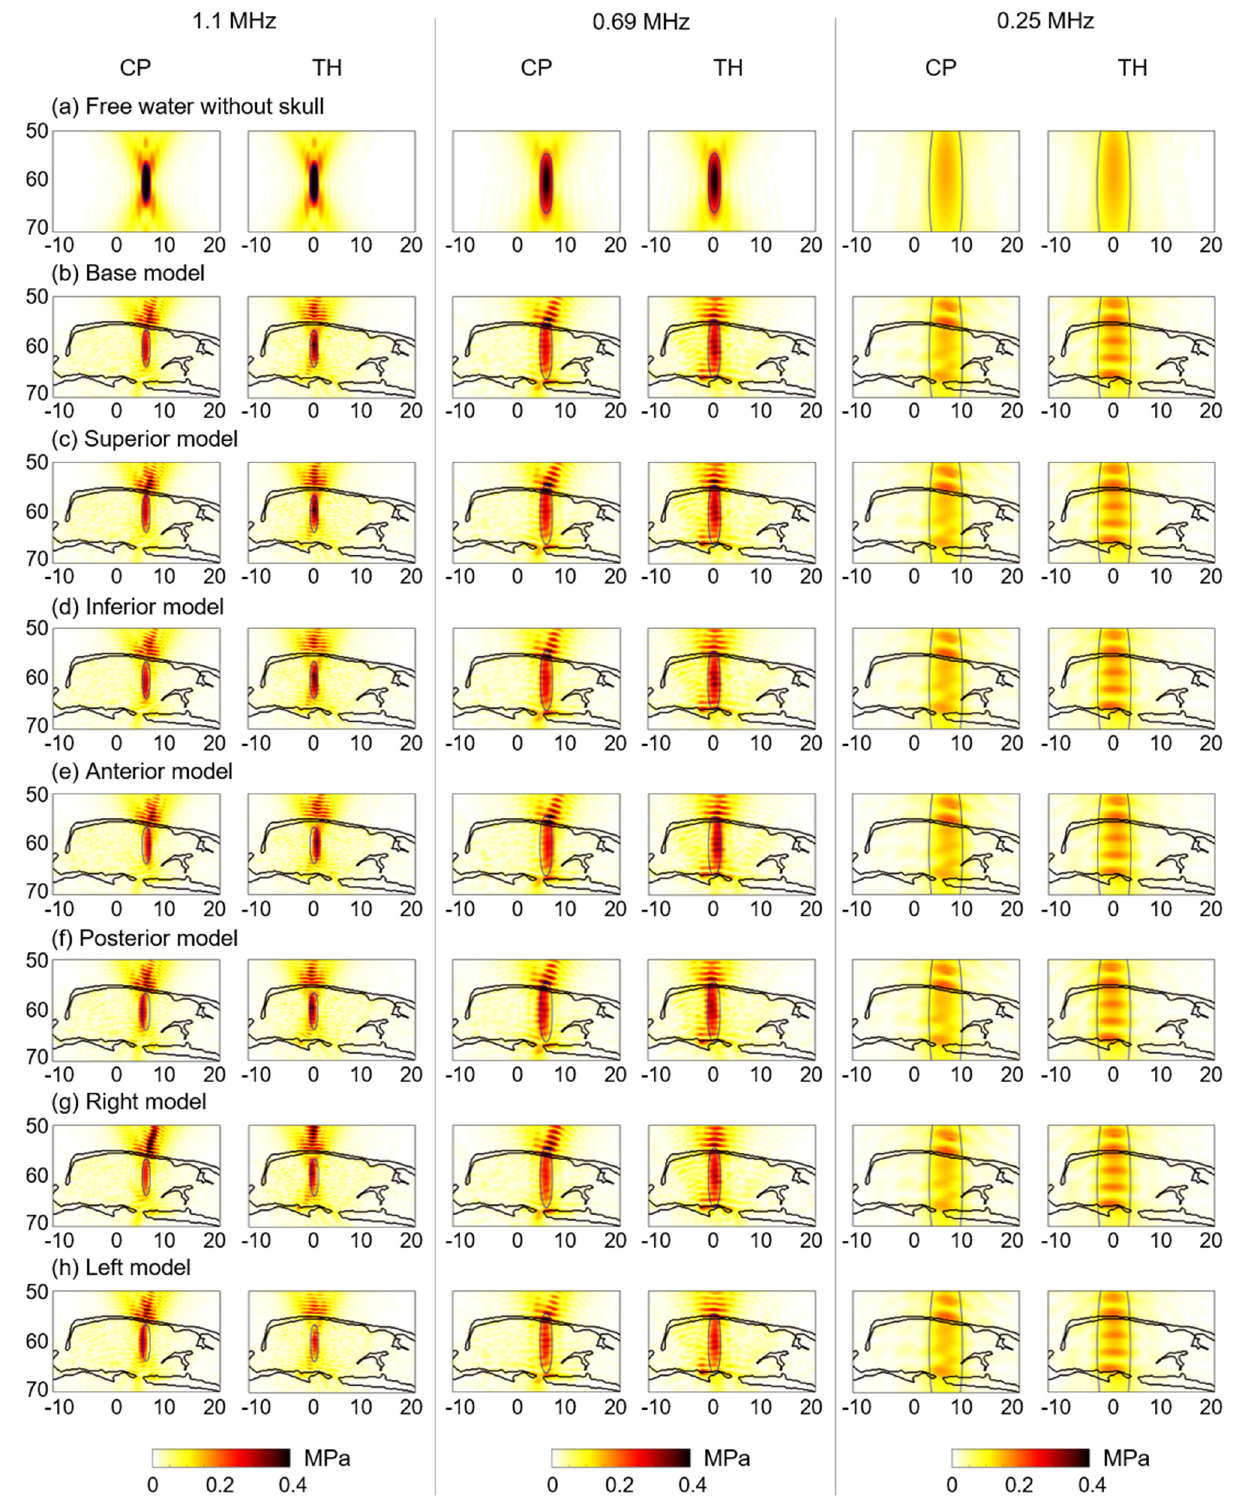
Figure 4. Acoustic distributions at 1.1, 0.69, and 0.25 MHz in the sagittal view ( a ) in free water and ( b ) after transcranial transmission for the CP and TH. The transducer is displaced by 0.5 mm in all six directions—( c ) +S, ( d ) +I, ( e ) +A, ( f ) +P, ( g ) +R, and ( h ) +L—relative to its base location. The blue lines denote the half − maximum pressure profiles in free water space.